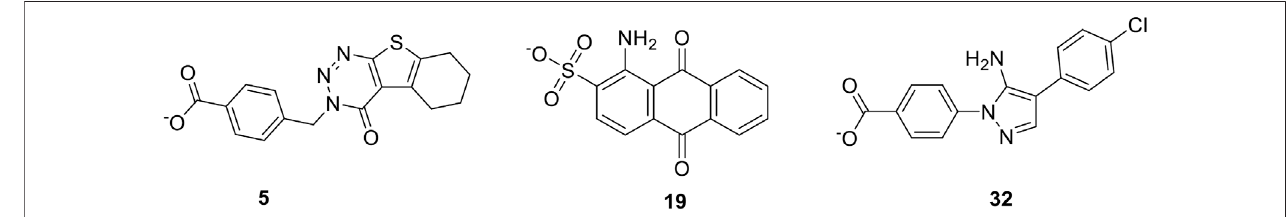
FIGURE 1 | The new T3SS inhibitors presenting in this work.